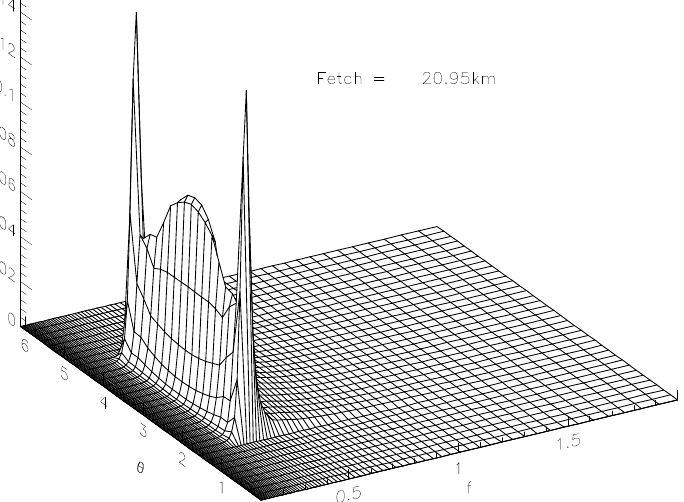
Figure 8. Spectral wave energy density ε as the function of the frequency ω and angle θ for PGZ-2